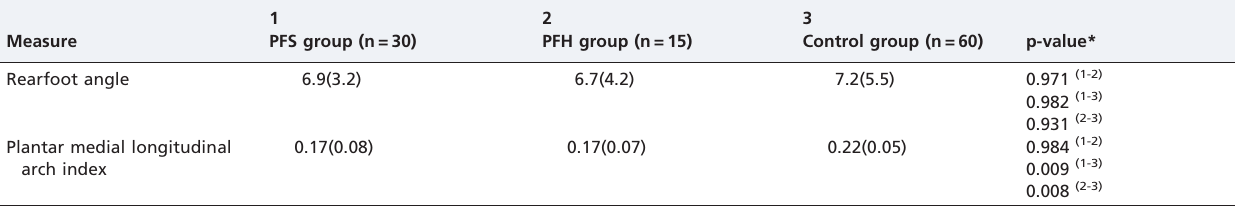
Table 2 - Descriptive statistics [mean (SD)] for the measures of alignment of the rearfoot and plantar medial longitudinal arch index between groups of runners with symptoms and histories of plantar